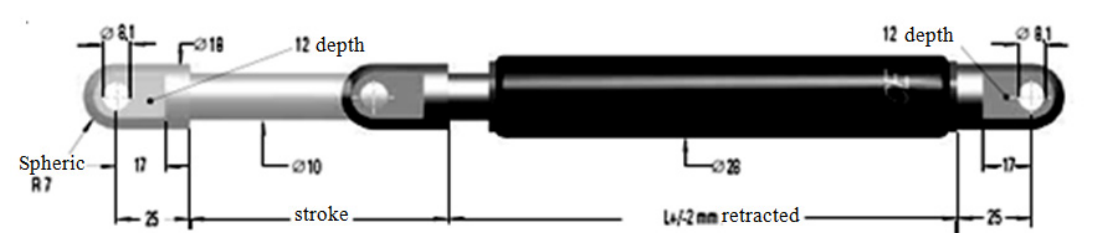
Figure 6: Gas spring. (ACE commercial catalog).